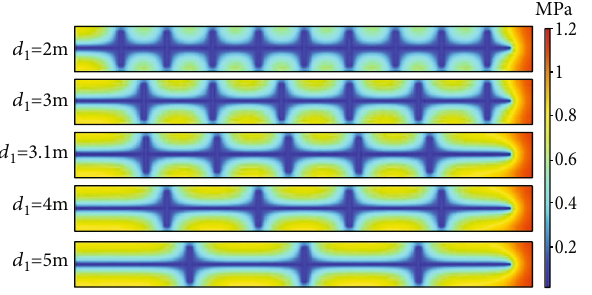
Figure 2: Gas pressure distribution in coal matrix under di ff erent slot spacing d 1 after 15-day